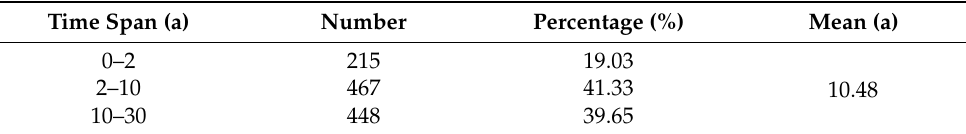
Table 1. Global GNSS observations’ duration.